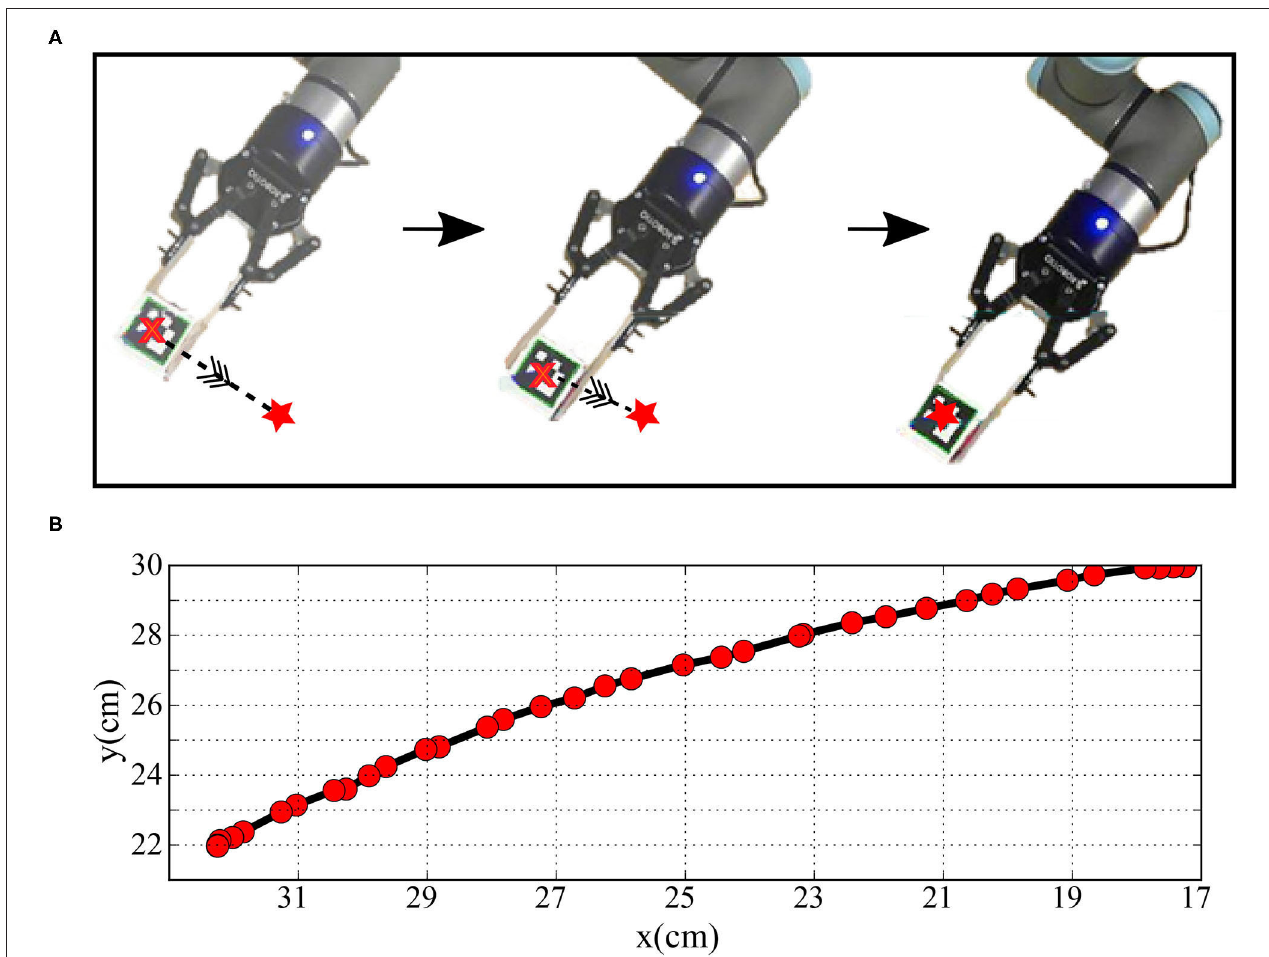
FIGURE 11 | (A) The robot arm while moving after training by the transformed data and (B) the plot of the Cartesian position of the end effector while